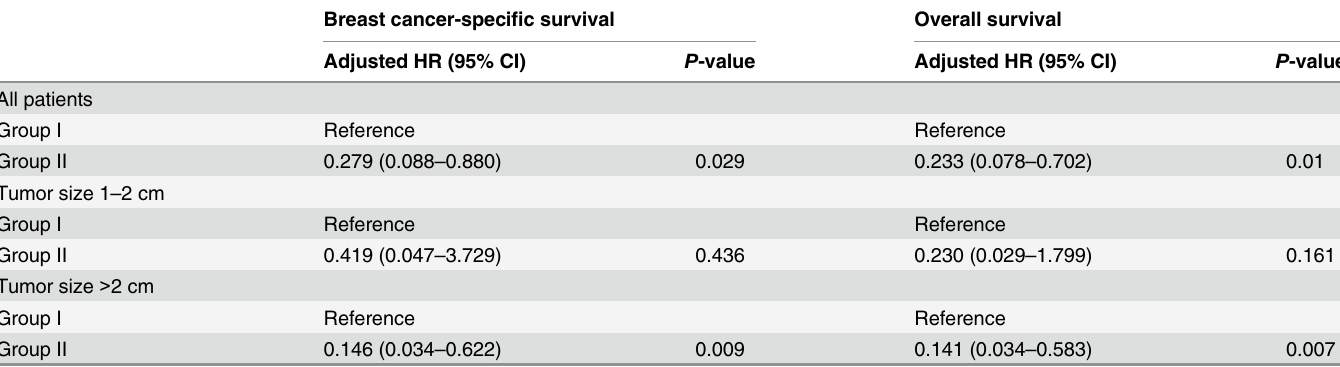
Table 3. Multivariate analysis evaluating the survival impact of adjuvant